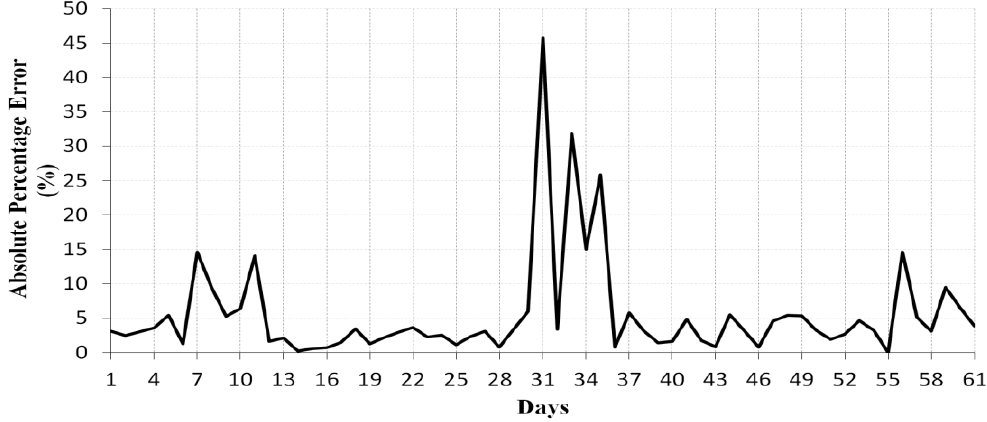
Figure 11. The lowest MAPE values achieved by the WOA-MLP method.